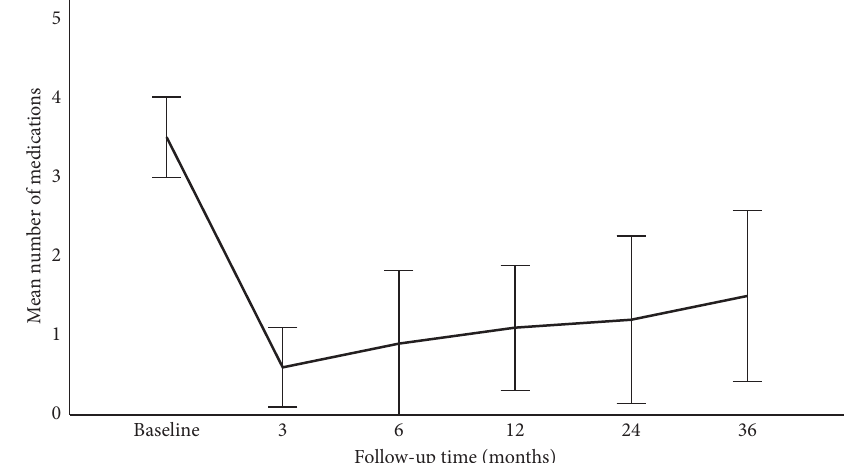
Figure 4: Mean number of medications at preoperative baseline and at subsequent postoperative time points after the implantation of the second Ahmed glaucoma valve. Whiskers represent the 95% confidence interval range of